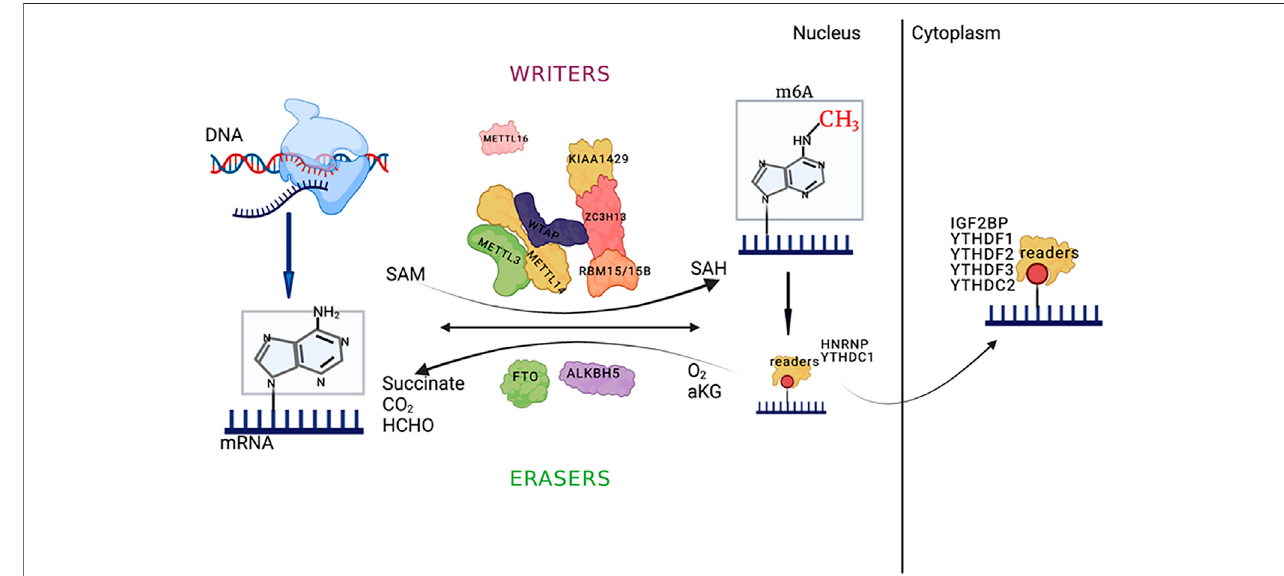
FIGURE 1 | The main processes of m6A RNA modi fi cation and the major enzymes involved; and the picture was created with BioRender. The key enzymes that catalyzem6Amethylation,suchasmethyltransferase(MT)complexes(METTL3/METTL14/Wilmstumor1-associatedprotein(WTAP)andotherregulatorycofactorsthat form the MT complex), or via methylation by METTL16 alone, are called “ writers. ” The demethylases that catalyze m6A demethylation (FTO/ALKBH5) are called “ erasers. ” YTHDF1-3/YTHDC1-2andIGF2BP1/2/3arecalled “ readers. ” Thereactionusess-adenosylmethionine(SAM)asamethyldonor,andthemethylgroupis removed to form SAH. The demethylation process for m6A RNA depends on Fe (II)/ α -ketoglutarate ( α -KG) and 2-oxoglutarate (2OG). The main functions of the binding proteins are to affect splicing, export and translation ef fi ciency. The schematic diagram was created with